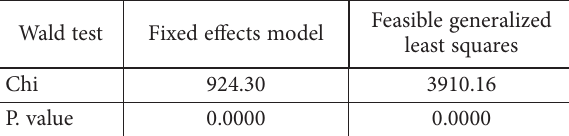
Table 2. Wald heteroscedasticity test